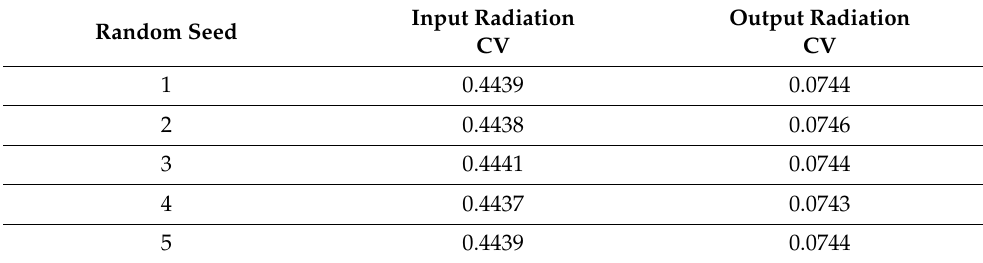
Table 2. Model dependence on the random number sequences. Random